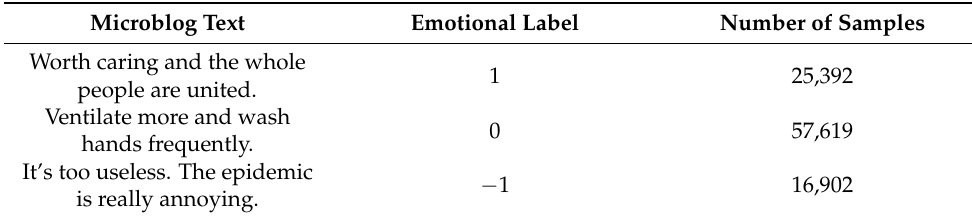
Table 1. Sample data set.